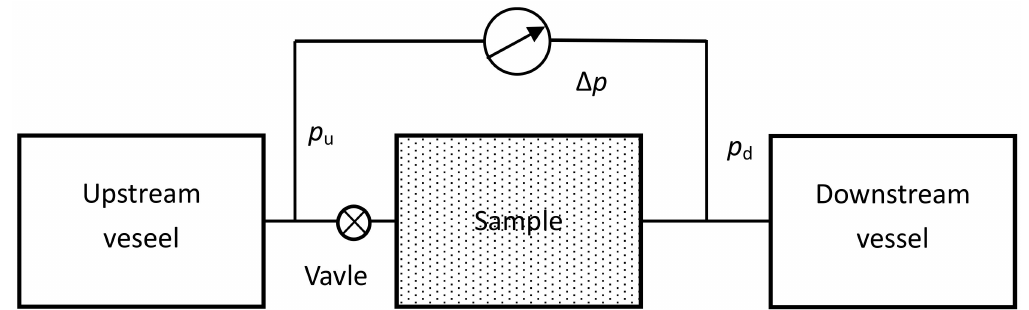
Figure 1. Schematic diagram of the apparatus for pulse decay